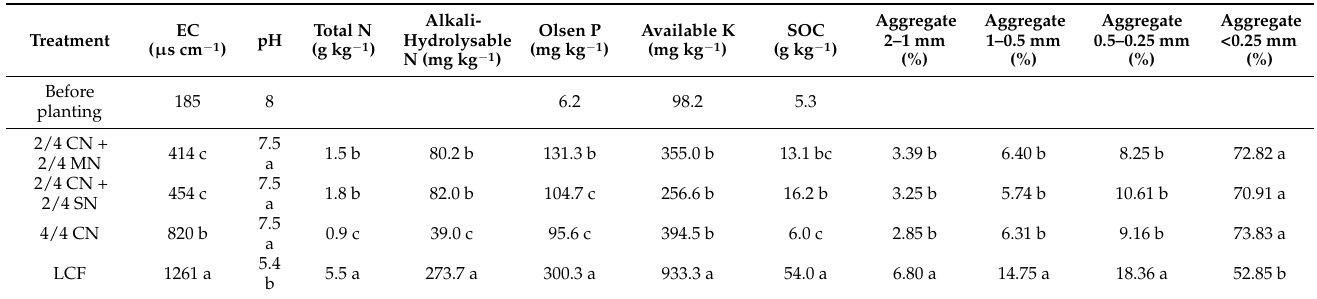
Table 2. Soil physicochemical properties of all treatments in 2018.